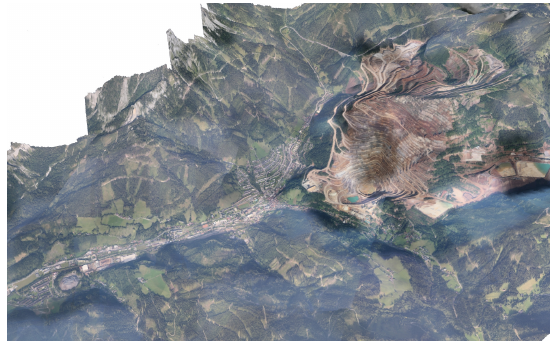
Figure 5. 3D view of Eisenerz based on ortho imagery and digital surface model generated from the 3D